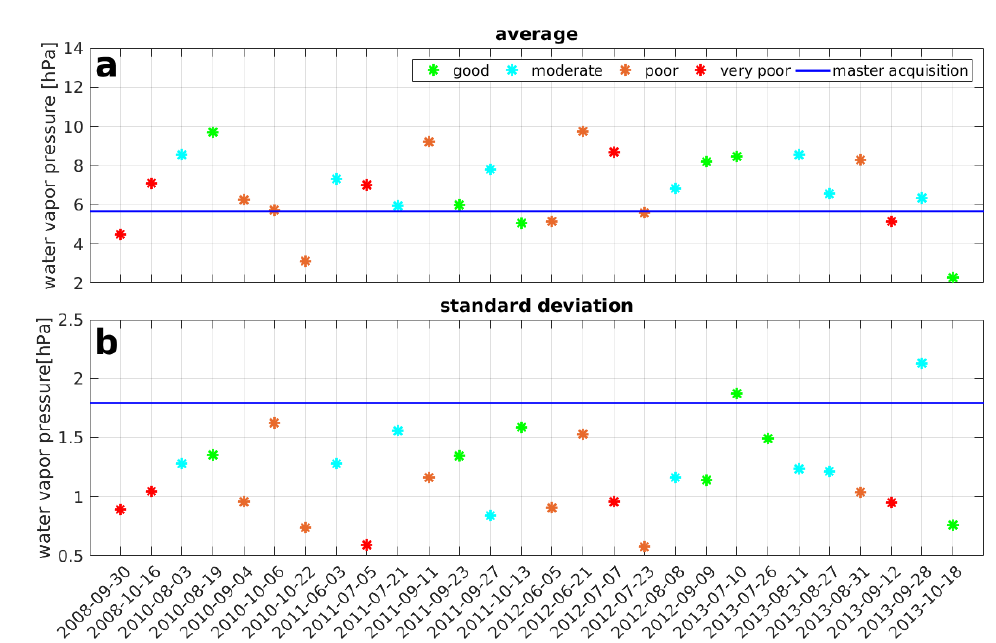
Figure 14. ( a ) the average values and ( b ) SD s of water vapor for each acquisition. The colors denote the level of agreement between InSAR and GNSS for these days. The navy blue lines indicate the values